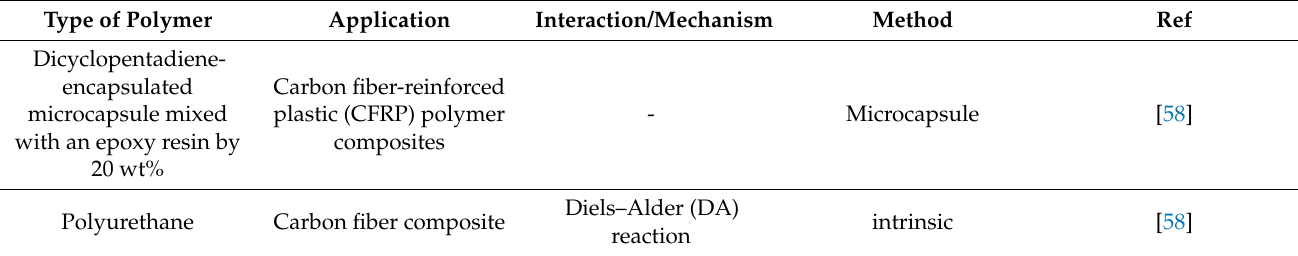
Table 3. Self-healing polymer composites in aerospace applications. Type of